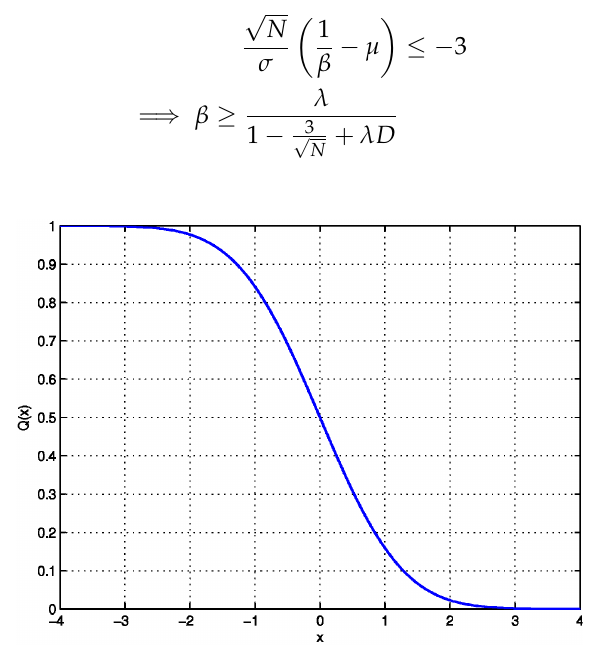
Figure A1. The Q